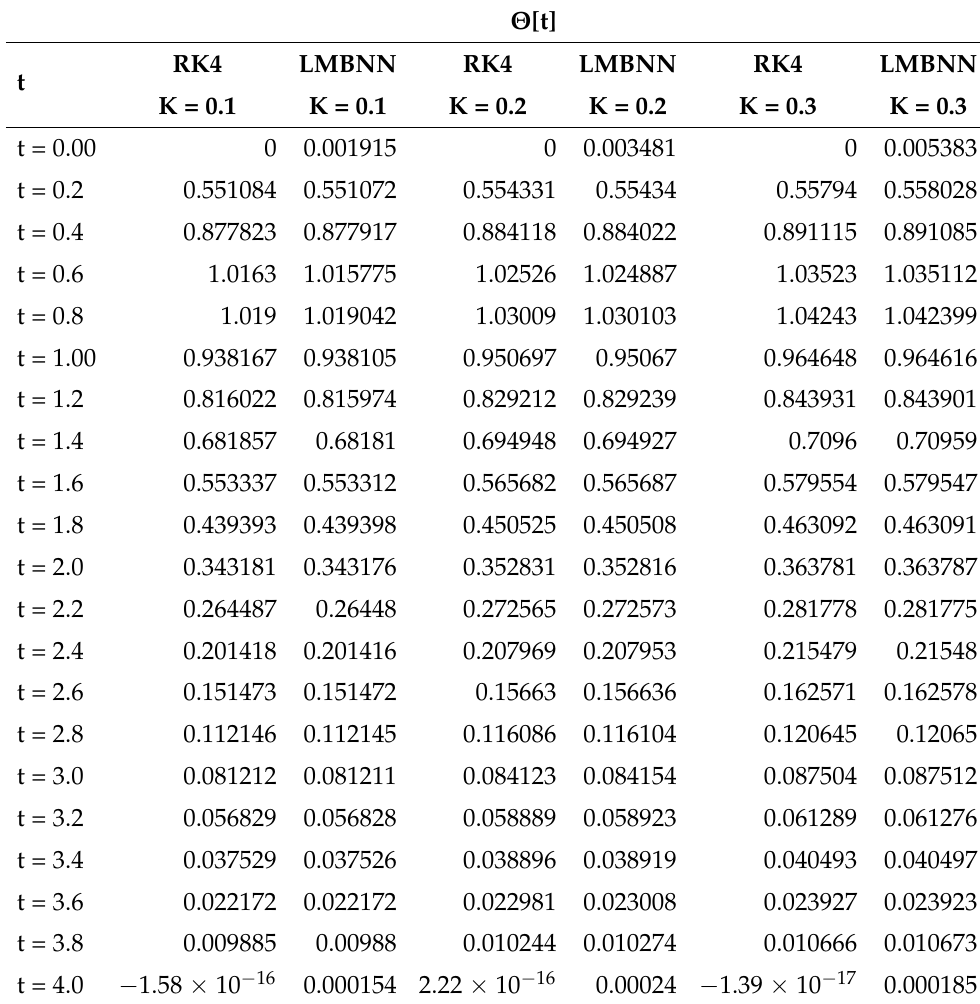
Table 5. Comparison of RK4 and LM-BNN in Θ using different values of rotation parameter